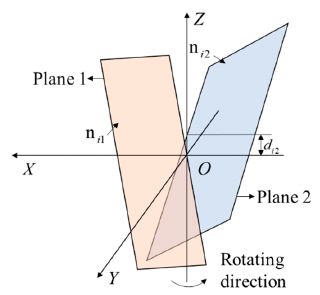
Figure 2. Schematic illustrating the scanning angle measurement of a laser transmitter station, where plane 1 and plane 2 are the two fan-shaped laser planes that rotate about the Z axis at a fixed rotational frequency.